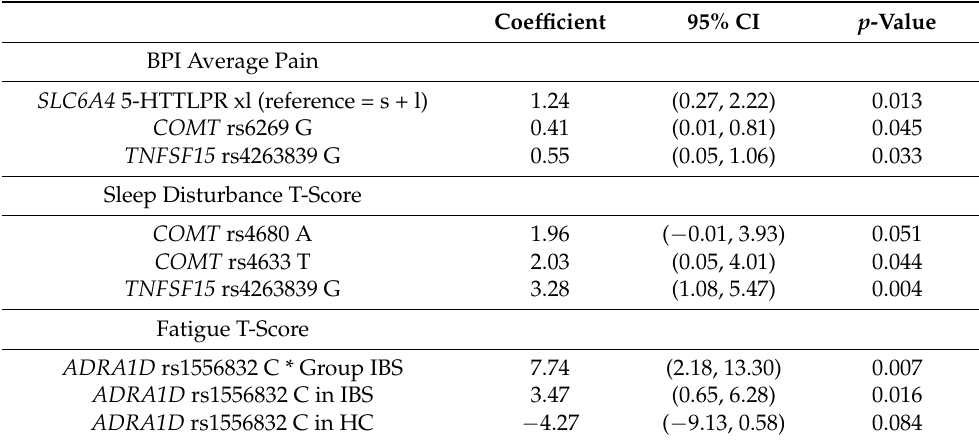
Table 3. Results of linear regression models for pain and psychological symptom measurements vs. SNPs.